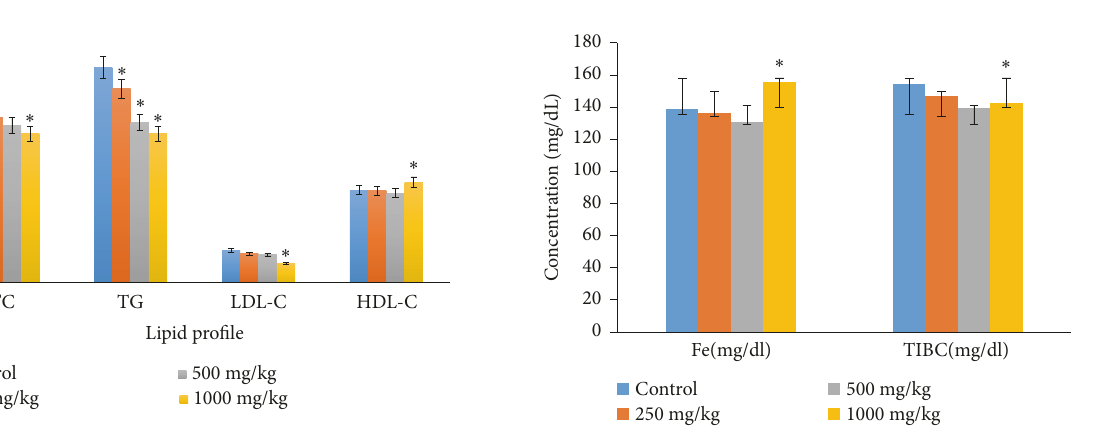
Figure 3: The effects of different concentrations of pomelo methanolic extracts on lipid profiles. Results are expressed as mean ± SD (n=8). ∗ denotes level of significant difference compared to control group (p < 0.05) as determined by using a one-way ANOVA followed by Dunnett’s multiple comparison tests.